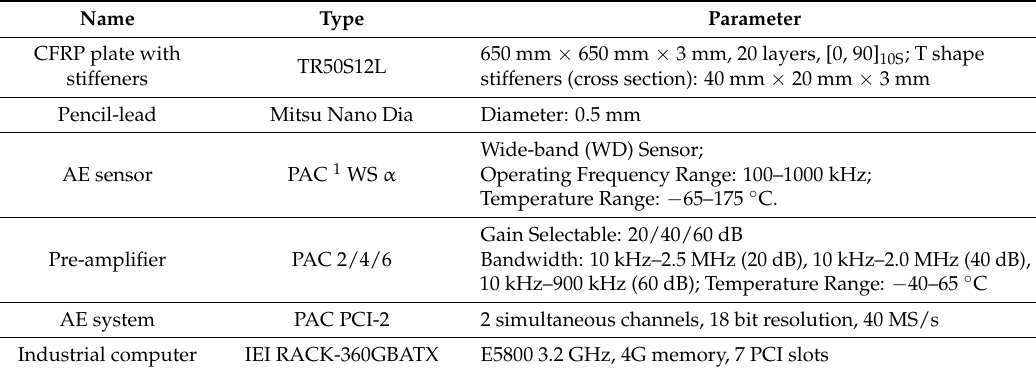
Table 1. The detailed information of the experimental system.